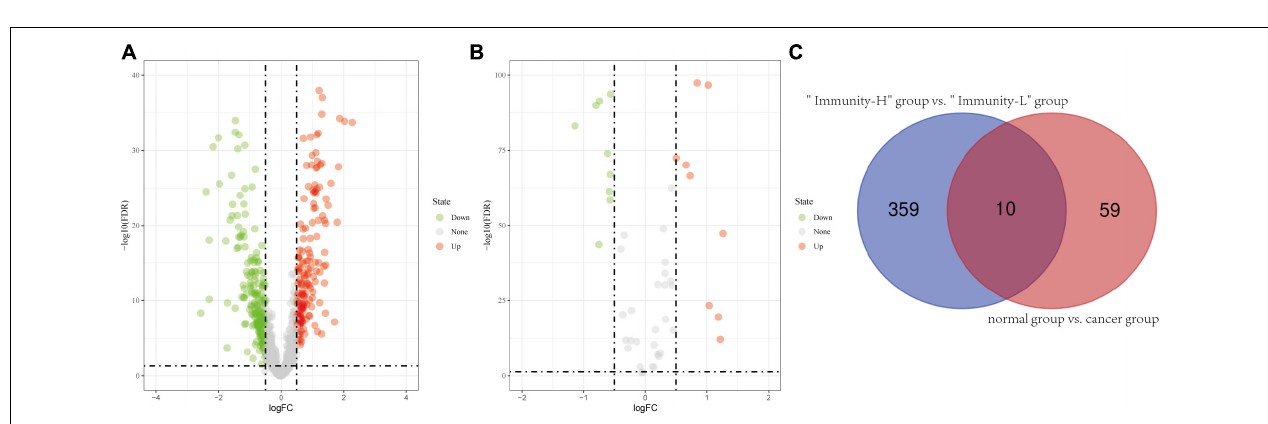
FIGURE 2 | Identification of differentially expressed lncRNAs. (A) Differentially expressed lncRNAs between the high immune infiltration group and the low immune infiltration group. (B) Differentially expressed lncRNAs between the cancer group and the normal group. (C) The intersection of differentially expressed lncRNAs is shown in the Venn diagram. “Immunity_H” and “Immunity_L” represent the high immune cell infiltration group and the low immune cell infiltration group, respectively.